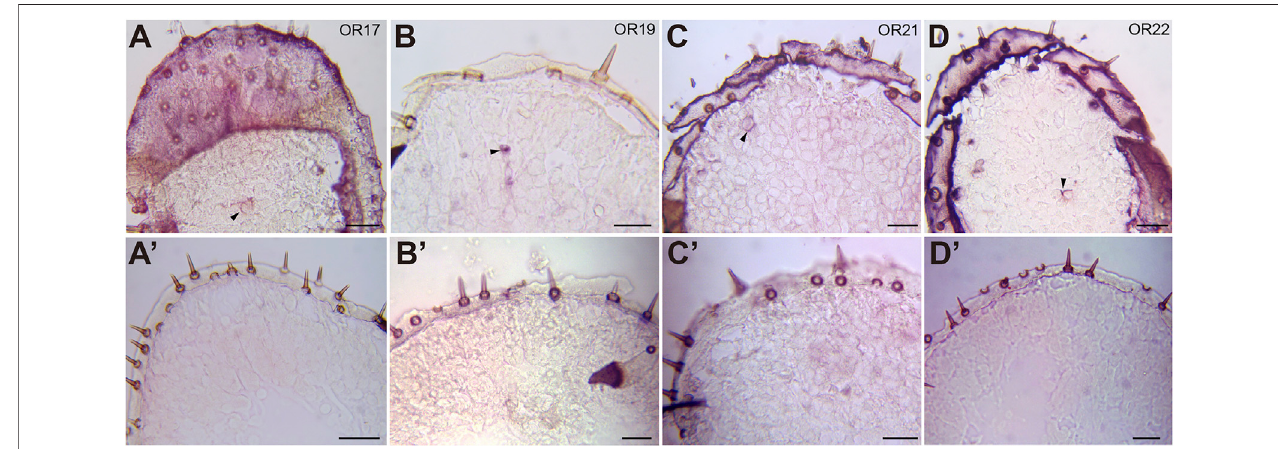
FIGURE2| ExpressionofORsinthemaxillarypalp ofthemigratory locust L.migratoria . Insitu hybridizationswereperformedonsections ofthemaxillarypalp with DIG-labeledantisenseprobesandsenseprobes.Signalswerevisualizedusingananti-DIGantibodyandcolorsubstrates. (A – D) ORNsexpressingOR17 (A) ,OR19 (B) , OR21 (C), and OR22 (D) were labeled. The black arrow indicates a cell expressing ORs. (A 9 – D 9 ) No neurons were labeled by sense probes of OR17 (A 9 ) , OR19 (B ’ ) , OR21 (C 9 ), and OR22 (D 9 ) . Scale bars: 50 μ